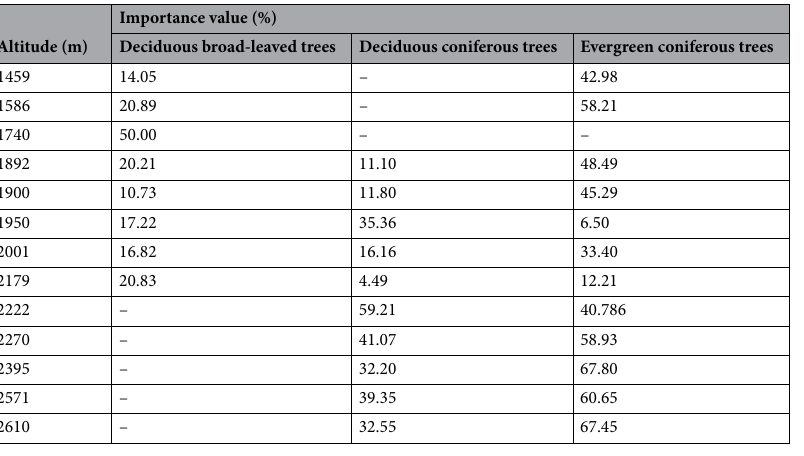
Table 2. Distributions of importance values of various tree species at different elevations. Thirteen elevations represent the tree community. Tree species are divided into deciduous broad-leaved trees, deciduous coniferous trees, and evergreen coniferous trees. “—” indicates no value at that elevation. At 1740 m, there was only one tree species, a deciduous broad-leaved tree. Data for different tree species were obtained from 20 sub- quadrats at each